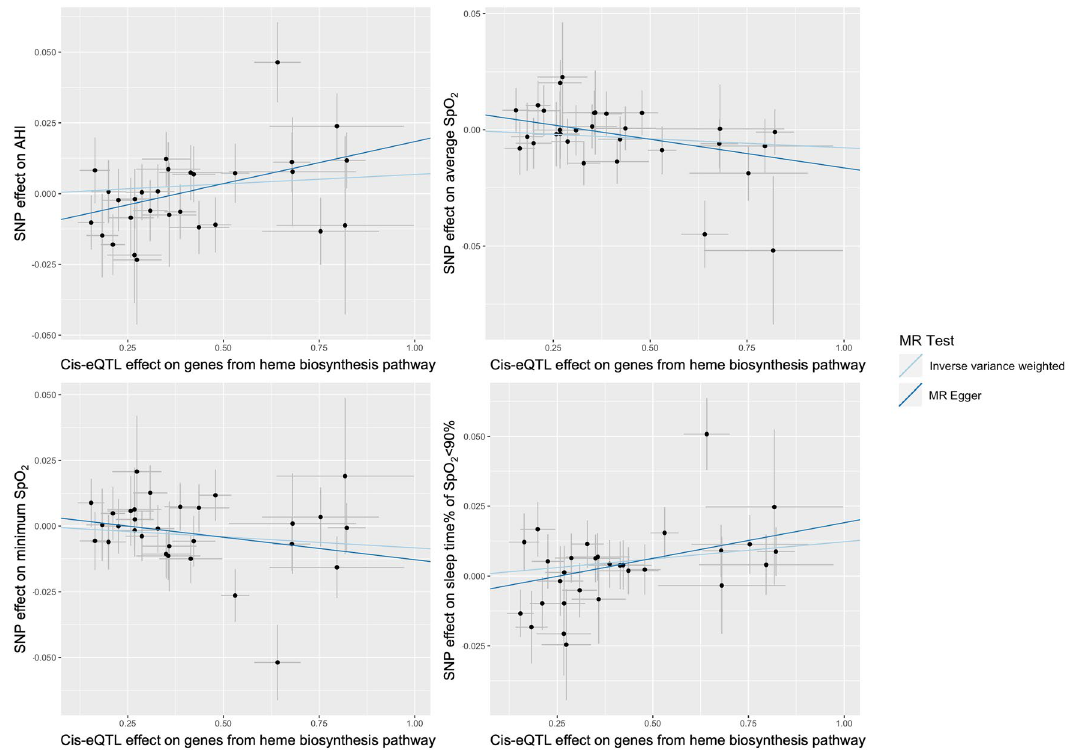
Figure 3. Scatter plots of SNP effects on the expressions of genes from Heme Biosynthetic Process pathway vs OSA traits in discovery analysis. Outcome Method Estimate S.E. p value Heterogeneity statistic IVW AHI